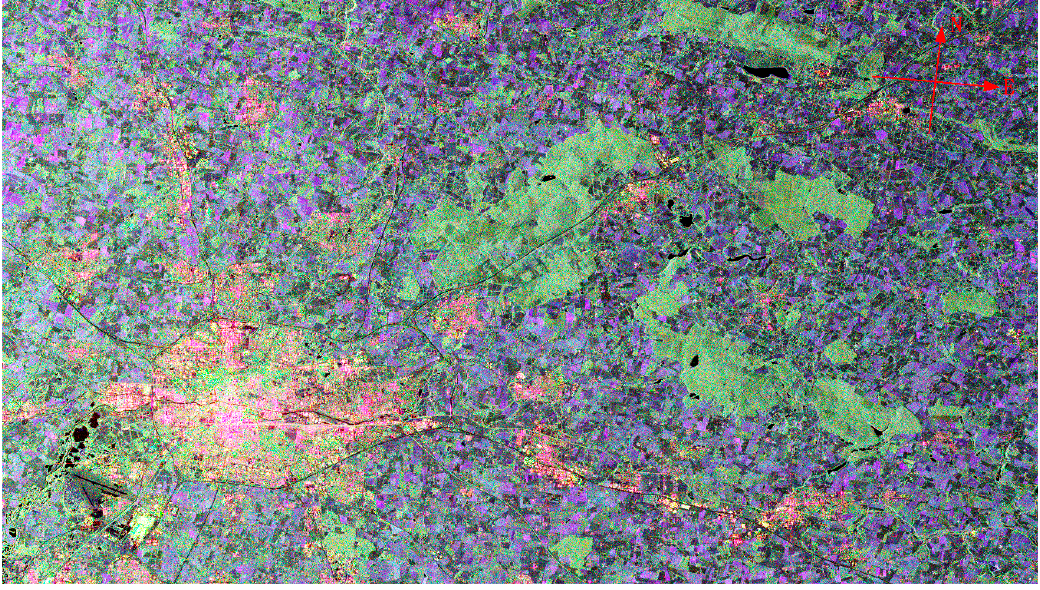
Figure 9. Q-mode image of Rennes city, France.